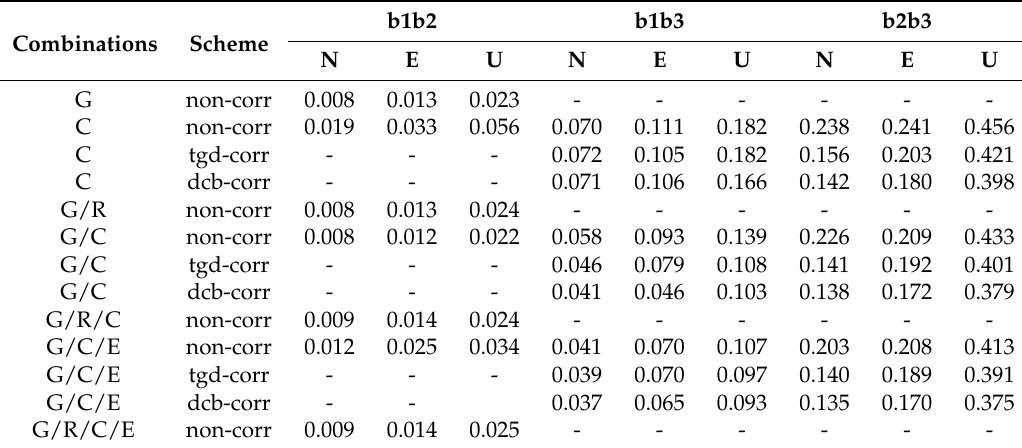
Figure 9. Positioning results (N, E, and U) of b2b3 GPS/BDS/Galileo PPP (unit: m). Table 5. RMS of multi-constellation PPP (unit: